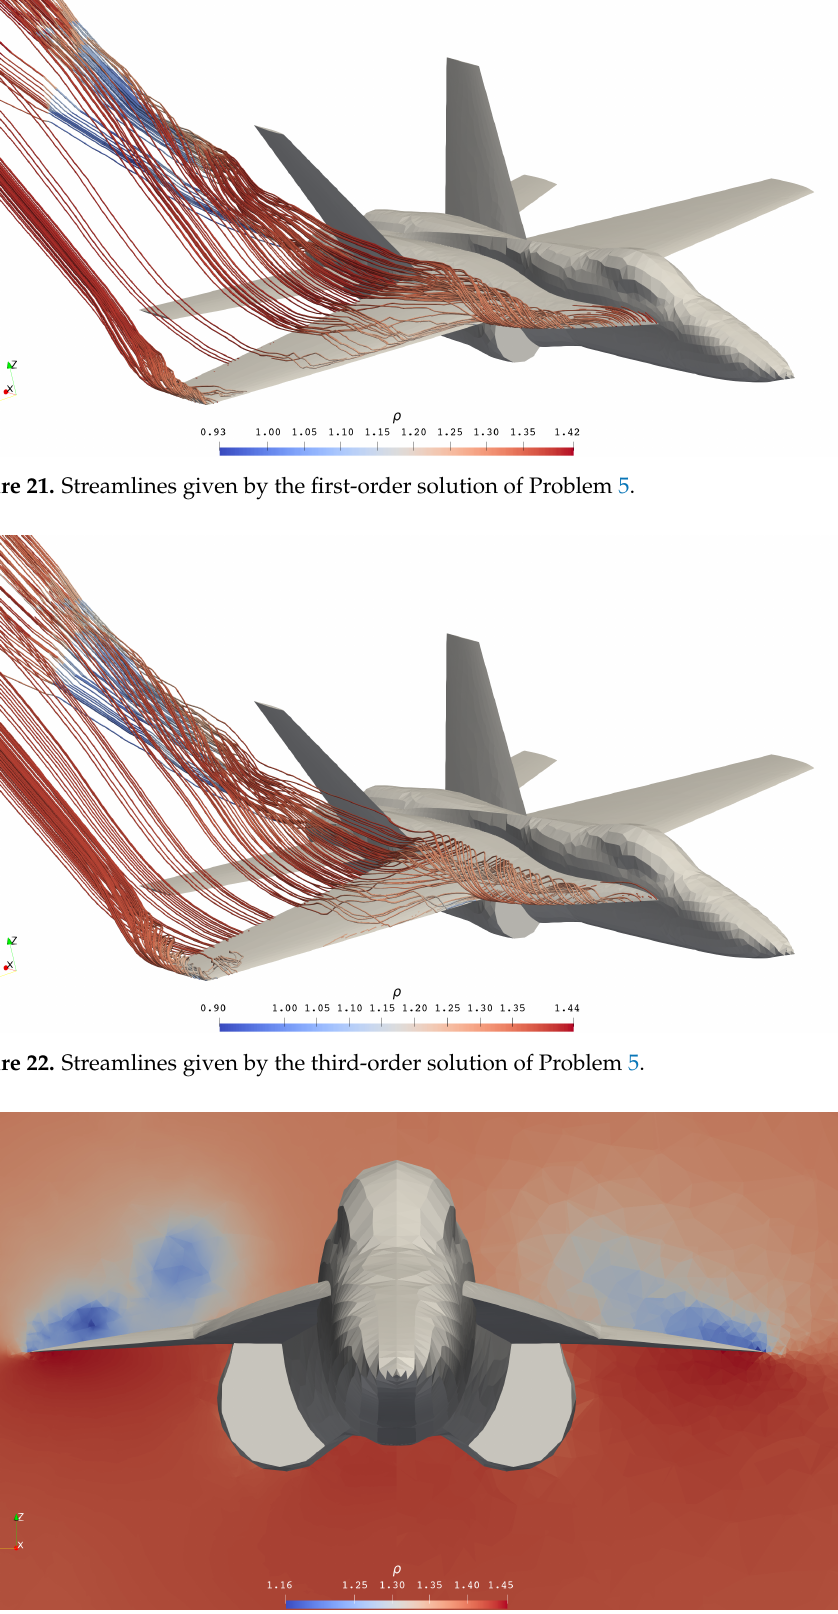
Figure 23. Comparison between the third-order solution (left half) and the first-order solution (right half) of Problem